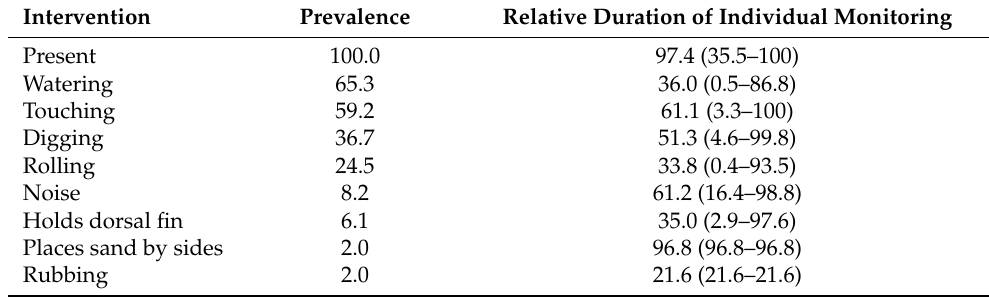
Table 6. Types of human intervention that occurred with individual focal stranded pilot